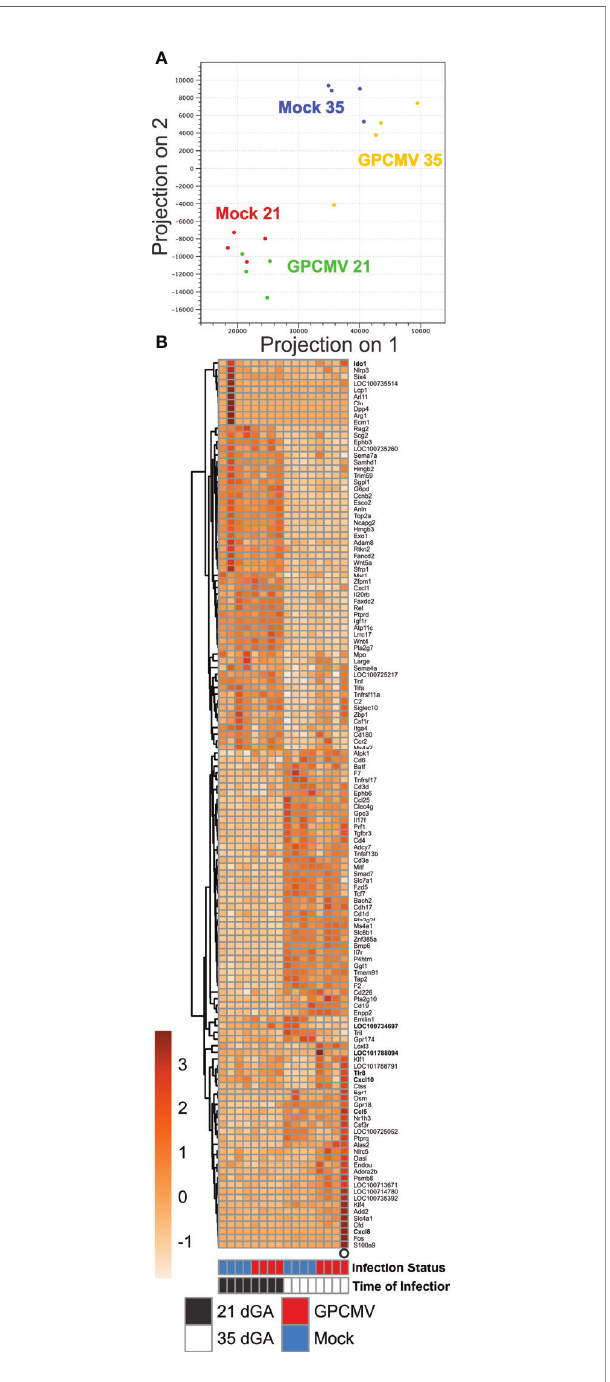
FIGURE 3 | Transcriptome pro fi ling of GPCMV-infected placenta. Time mated guinea pigs were GPCMV- or mock-infected at 21 or 35 dGA and euthanized 21 days later. RNA was extracted from placentas (N=4/group) and gene expression was quanti fi ed by Illumina RNA-Seq. (A) Principal component analysis illustrating the similarity in gene expression between samples. (B) Heat map illustrating the relative expression of transcripts that function as part of an immune system processes (GO:0002376) that were differentially expressed in placenta either during normal development or after GPCMV infection. Transcripts that were also analyzed by RT-ddPCR are shown in